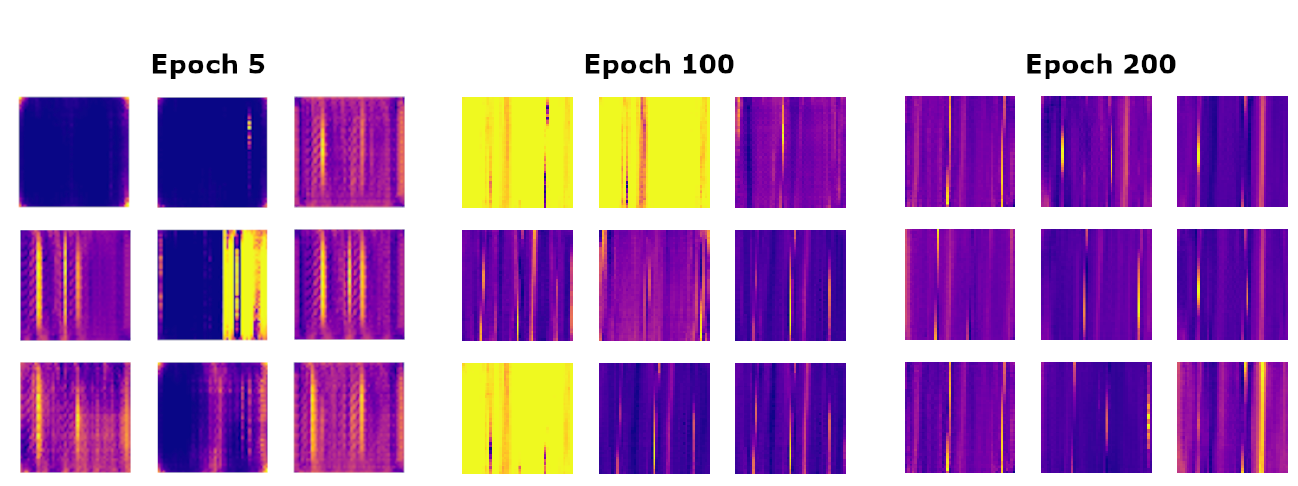
Figure 11. Generated Cardiogram images samples in transposed arrangement through 200 epoch training with a CNN